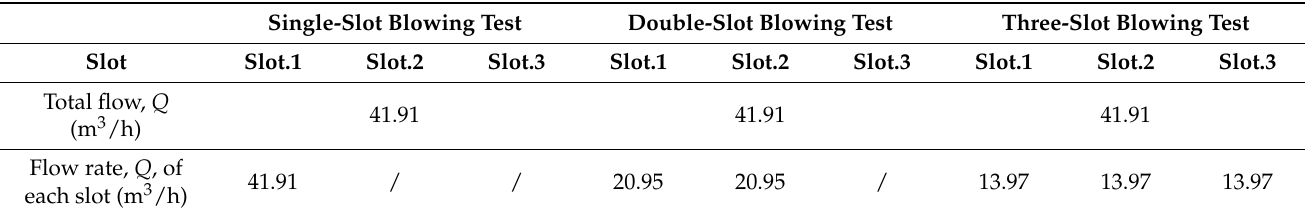
Table 2. Experimental parameters of variable number of slots.